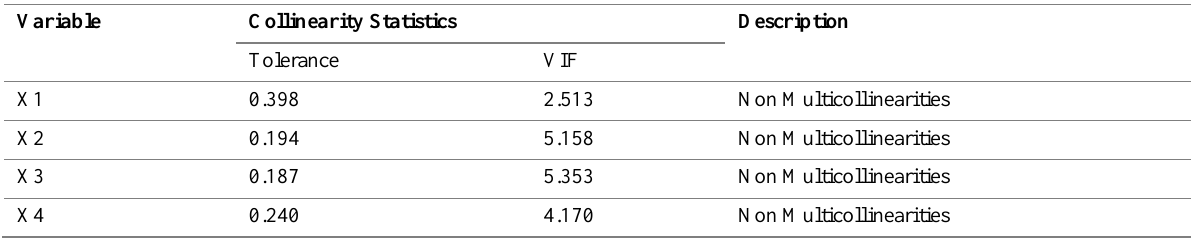
Table 5: Multicollinearity Test